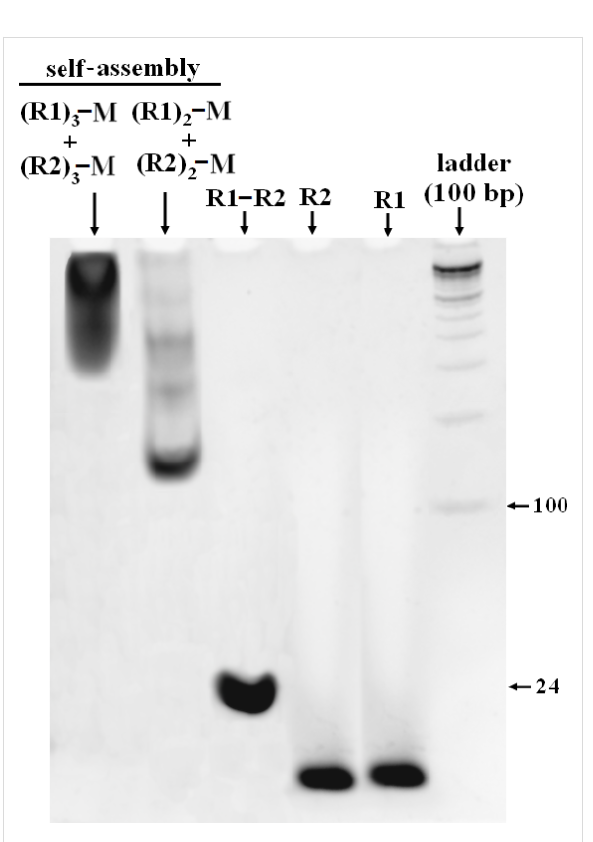
Figure 3: 10% non-denaturing PAGE showing the difference in gel mobility of R1–R2 and the corresponding DNA–melamine conjugates in self-assembly, where M =